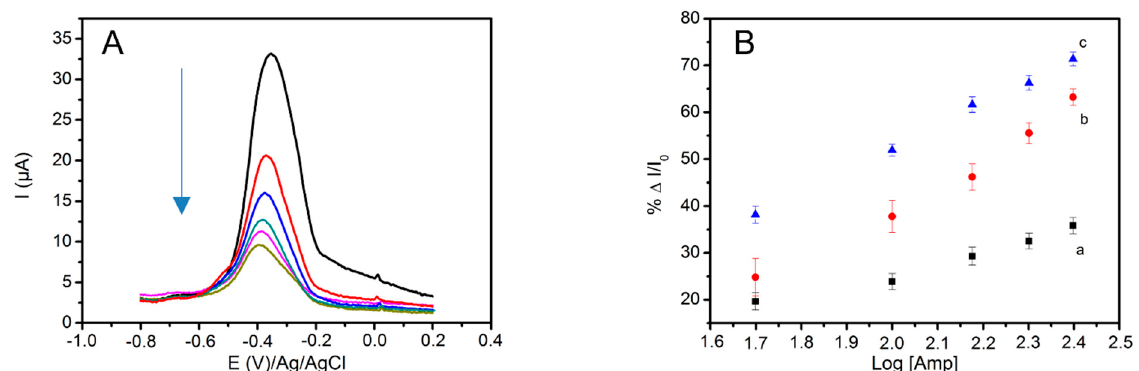
Figure 5. ( A ) SWVs of the oxidation peak after incubation at ampicillin concentrations of 50, 100, 150, 200, and 250 pg/L in PBS for the MoS2/PPy based electrode; ( B ) calibration curve of the biosensor displaying the relative changes of the current peak % ∆ I/I0vs Log [AMP] for ( a ) SPCE/MoS2/NQ/APT, ( b ) SPCE/PPyNPs/NQ/APT, and ( c )